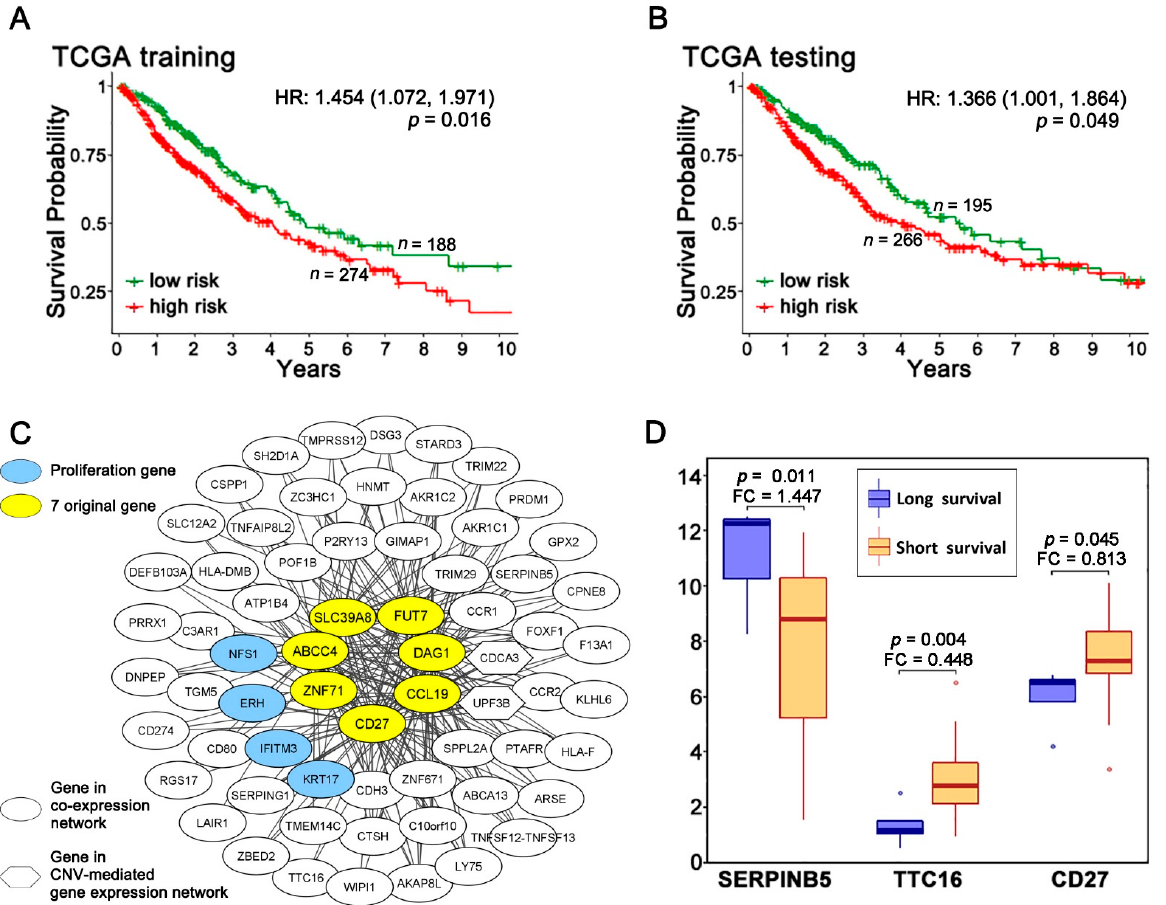
Figure 1. The 7-gene signature and associated multi-omics network. Kaplan–Meier analysis of 7-gene signature in training ( A ) and testing ( B ) sets randomly partitioned from the combined TCGA-LUSC and TCGA-LUAD data. Patients were grouped by risk-scores with the cutoff value of − 0.74. The plots show the survival outcome of the first 10 years after surgery. ( C ) The multi-omics network of the 7-gene signature in NSCLC tumors. All proliferation genes in the networks were identified from CRISPR-Cas9/RNAi screening data in CCLE NSCLC cell lines, with more details provided in Supplementary File S2. ( D ) Genes associated with radiotherapy response. In TCGA-LUSC and TCGA-LUAD, these genes showed significantly different expression levels ( p < 0.05, two-sample t -tests) between the long survival group (>58 months; n = 144) and the short survival group (<20 months; n = 186). Analysis was conducted on stage III or IV patients who had received radiotherapy. Stage III and IV NSCLC patients receive radiation therapy [6]. To identify genes as- sociated with the response to radiotherapy, TCGA-LUAD and TCGA-LUSC stage III and IV patients who had received radiotherapy were included in the analysis. There was sig- nificant differential expression ( p < 0.05, two sample t -tests) in genes identified in the